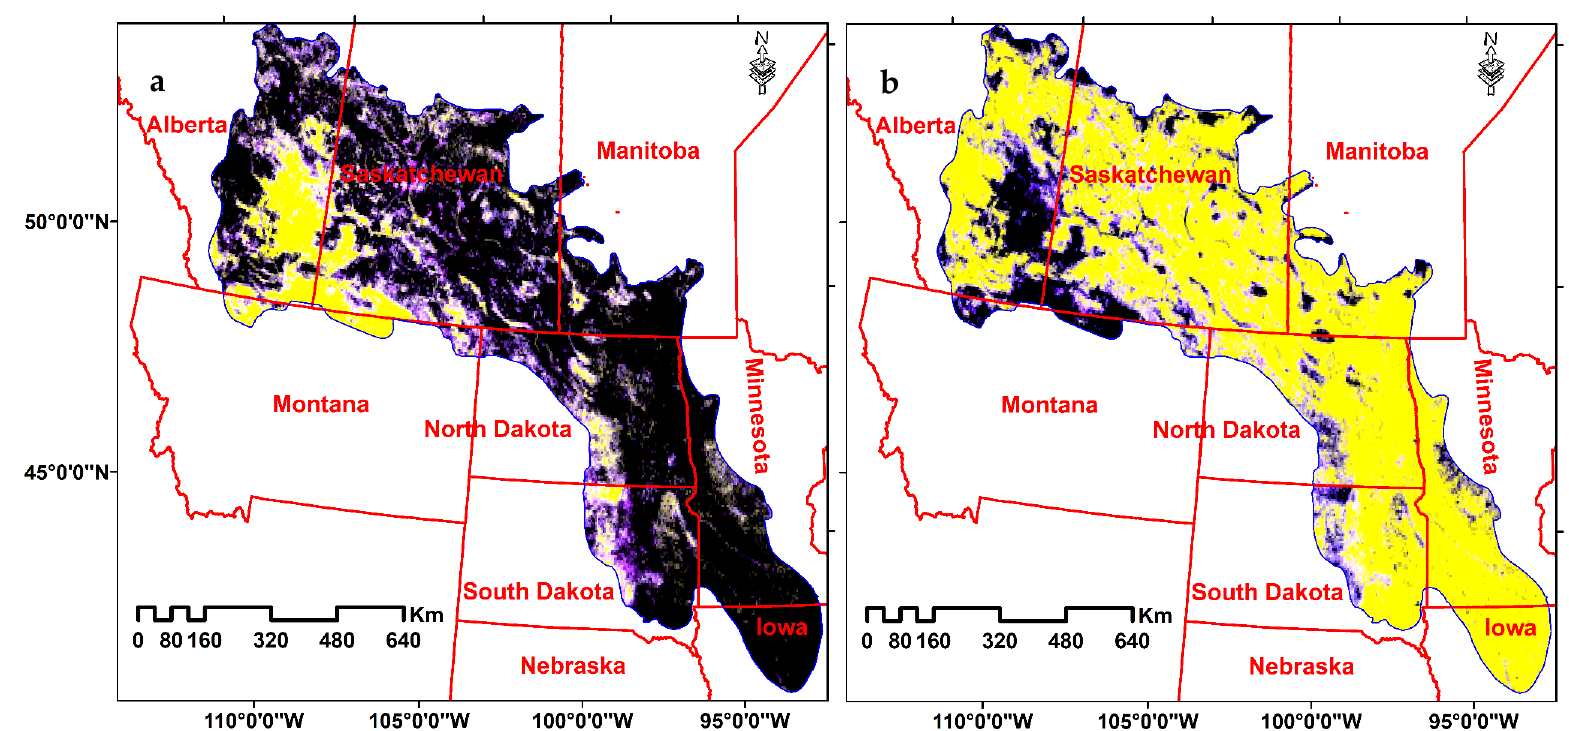
Figure 1. Land cover persistency map for ( a ) grasslands and ( b ) croplands based on MODIS 0.05° cropland and grassland percentages from the International Geosphere Biosphere Programme (IGBP) MCD12C1 time series from 2006 through 2017 [27]. The false color composite images were generated in such a way that the maximum percentage of cover type during the study period was displayed in the red panel; the mean percentage in the green panel; and the range in the blue panel [28,29]. See Table 1 for the interpretations of the map colors.